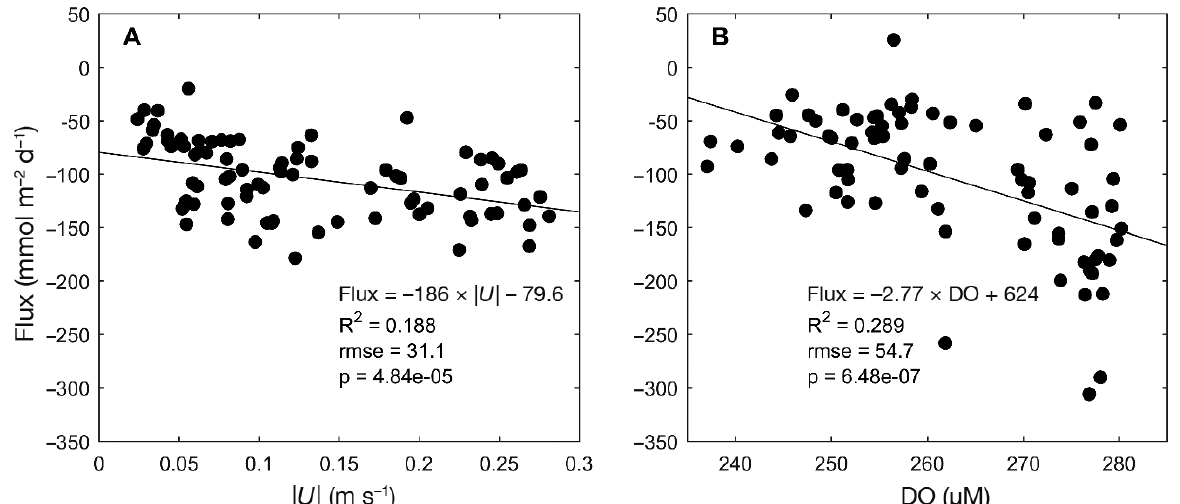
Fig. 6. Flux versus (A) current speed ( U) at site H3 and (B) dissolved oxygen (DO) concentration at Site L. The solid lines show best fit linear